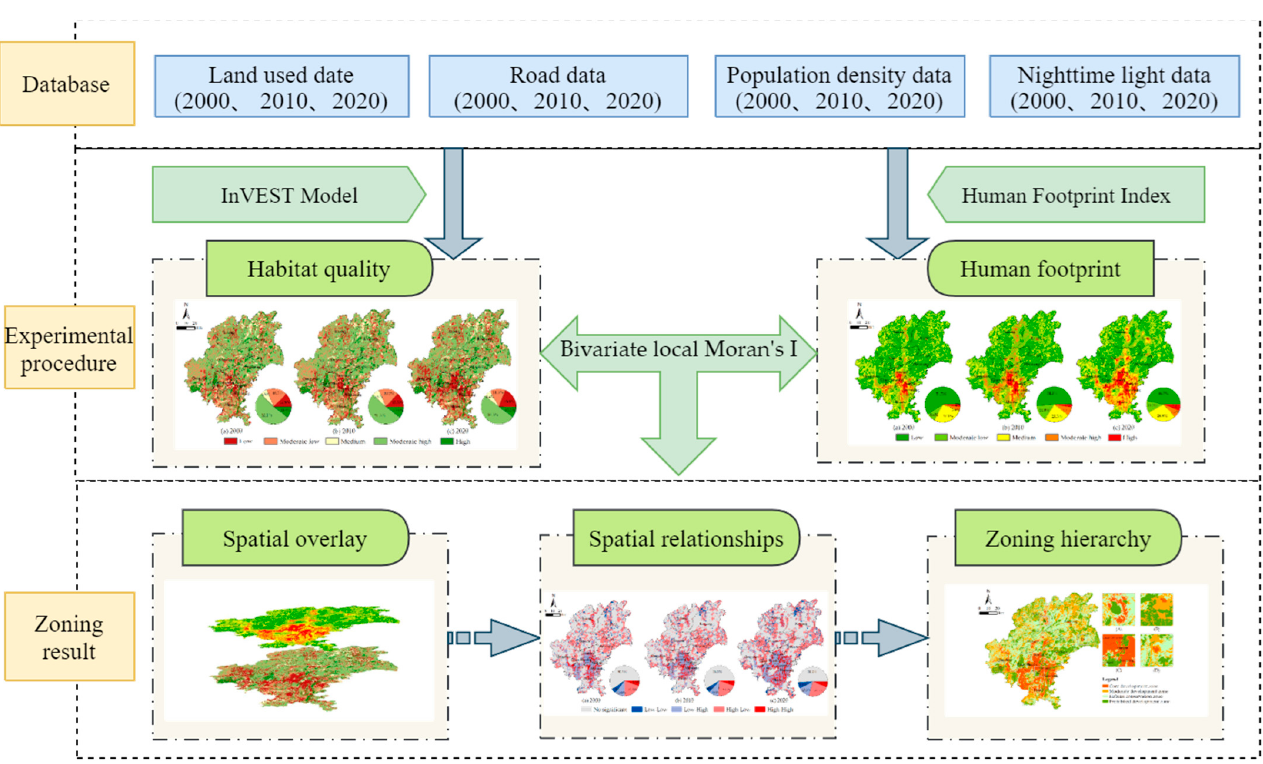
Figure 2. The Framework of this study.